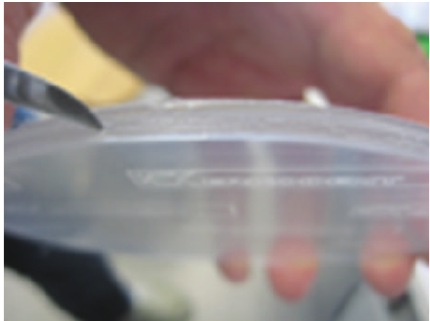
Figure 3: Thermoforming disc, the double matrix is high-lighted.